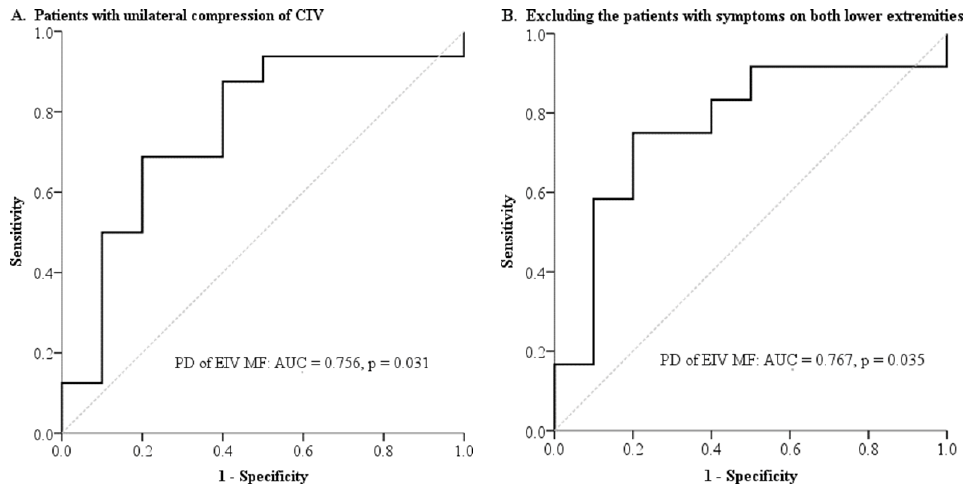
Figure 4. ROC curves for PD of EIV MF for predicting the occurrence of symptoms in the compres- sion-side lower extremity ( A ) and after the exclusion of patients with bilateral symptoms ( B ). Ab- breviations: DVT, deep vein thrombosis; EIV, external iliac vein; MF, mean flux; PD, percentage difference.